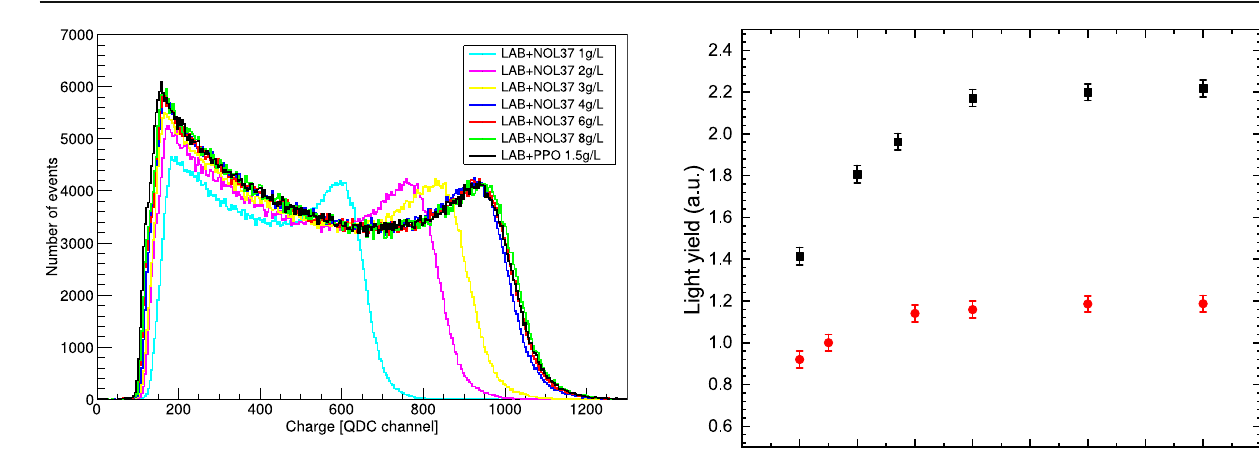
Fig. 3 Results of light yield measurements of liquid scintillators with NOL 37 fluor under irradiation by 662 keV gamma-quanta from 137 Cs radioactive source